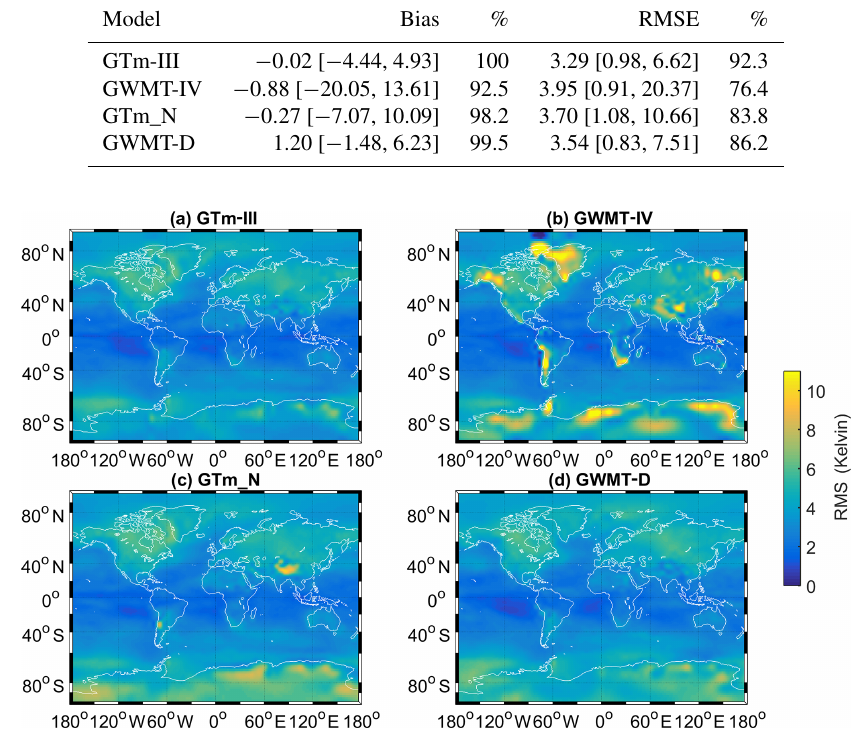
Figure 7. The global RMSE distribution of the differences between surface T m derived from each model and GGOS data in